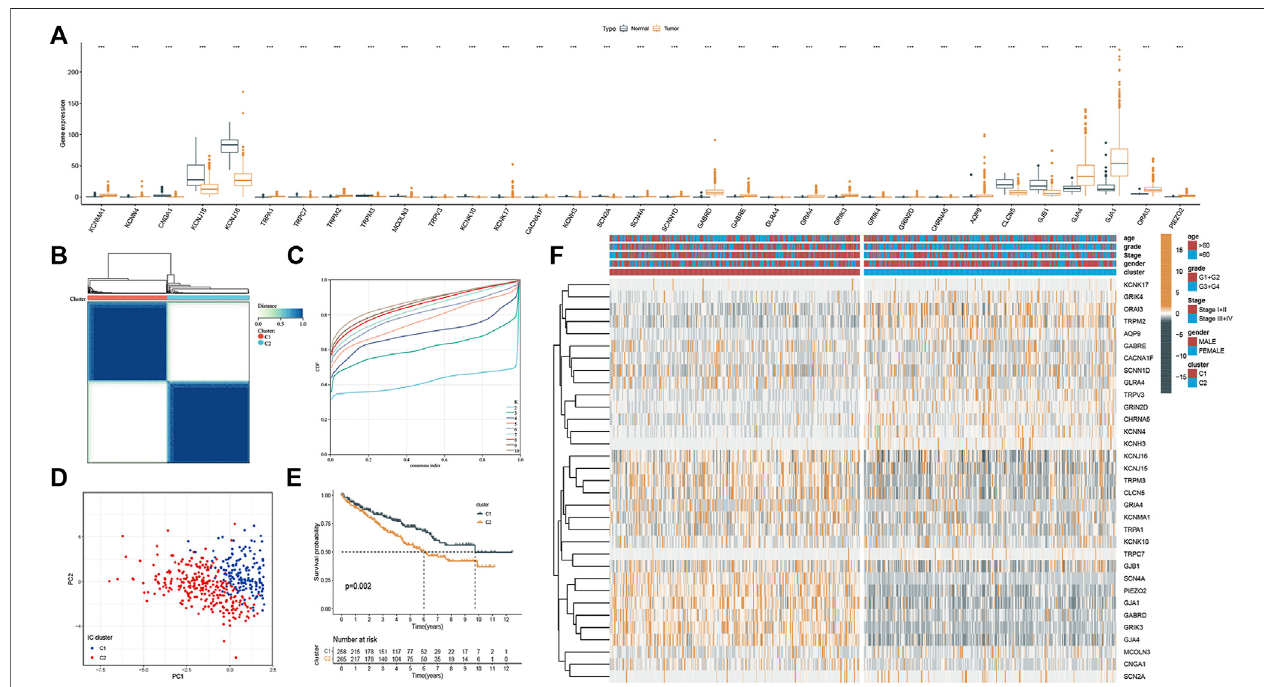
FIGURE 4 | Molecular subtyping based on the ICRGs in TCGA cohort. (A) Box plot of the 33 DEGs between tumor and normal samples. (B) Total of 374 ccRCC patients were identi fi ed into two clusters according to the consensus clustering matrix (k = 2). (C) Relative changes in the area under the CDF curve by group number (MaxK =10). (D) Principalcomponentanalysisonthetwoclustersbasedonthe33DEGs. (E) Kaplan – Meiersurvivalcurvesforthetwoclusters( p =0.002). (F) Heatmap and the clinical parameters of the two clusters established by 33 DEGs (the more yellow the color, the higher the level of gene expression. The bluer the color, the lower the level of gene